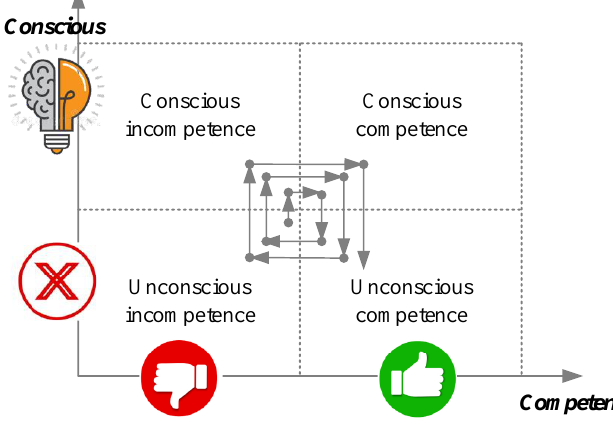
Figure 3. Four-link spiral of professional competency